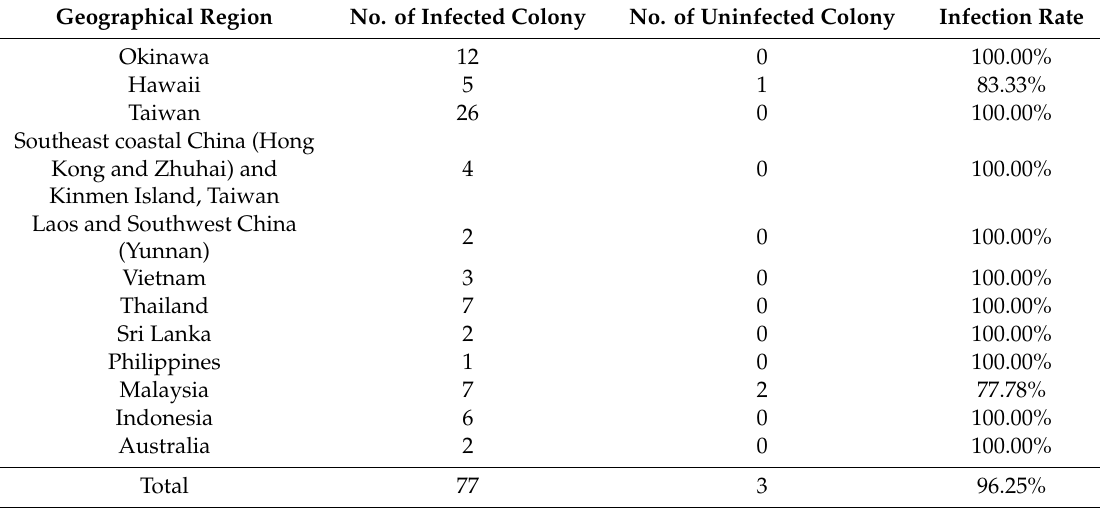
Table 1. Wolbachia prevalence in Anoplolepis gracilipes across all sampled regions. Geographical Region No. of Infected Colony No. of Uninfected